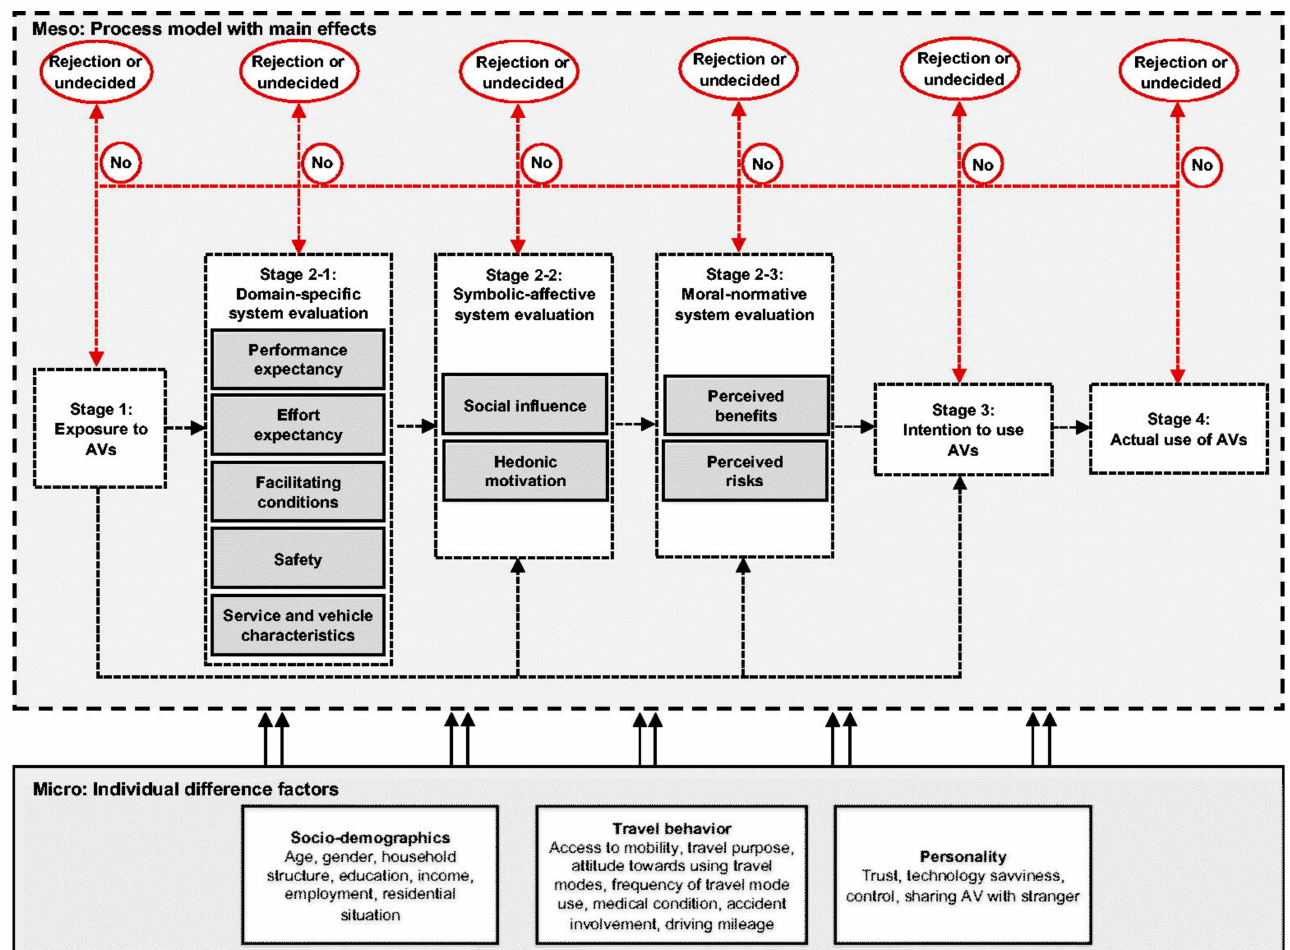
Figure 1. The Multi-Level Model on Automated Vehicle Acceptance (MAVA) proposed by Nordhoff et al. (2019) [43]. Reprinted from ref. [43].